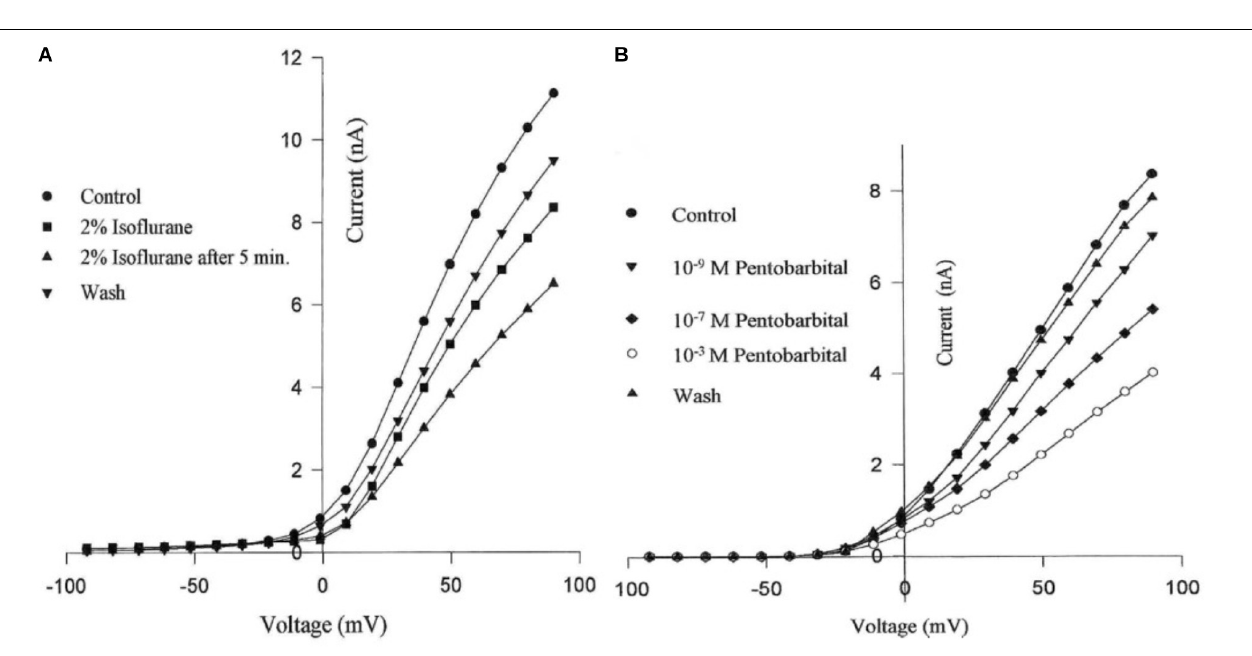
FIGURE 3 | Dose dependent depression of peak current and endpulse current in a PeI cluster cell of Lymnaea stagnalis. The Cell was held at a holding potential of –50 mV and 180 ms long depolarizing pulses were applied in 10 mV increments in control (snail saline), 0.5, 1.0, 2.0, and 4.0% halothane. There is a very clear reduction of calcium channel current which is concentration-dependent. The peaks of the I-V curves are not shifted by halothane. (From Yar and Winlow, 2016 – Reproduced under the Creative Commons License).